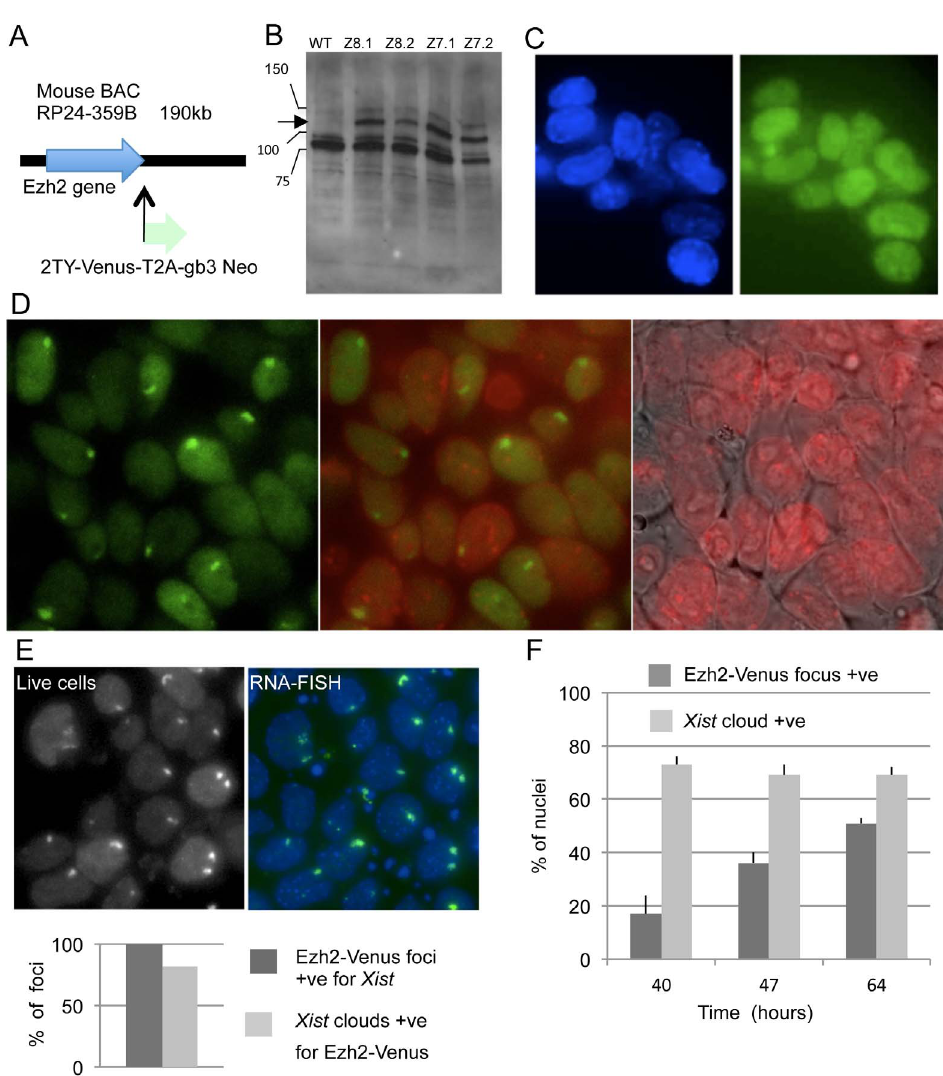
Fig. 2. The Ezh2-Venus protein is recruited at the nascent inactive X chromosome in differentiated ES cells. A) Schematic strategy for the COOH-tagging of the Ezh2 protein expressed from a mouse BAC DNA. B) Expression of the Ezh2-Venus fusion protein in ES cells. Western blotting using an Ezh2 antibody and nuclear extracts from the parental ES cell line HP3-10 (WT) and from four neomycin-resistant clones transfected with Venus-tagged BAC DNA The arrow points to the migration level of the fusion protein. C) Nuclear localization of the Ezh2-Venus fusion protein in fixed ES cells. Wide-field fluorescent microscopy for Hoechst 33342 (blue, left panel) and Venus (green, right panel) of the Z8.1 ES cells cultured in 2i plus LIF and fixed for 3 minutes with 4% PFA. D) Ezh2-Venus nuclear foci are detectable in differentiated live female ES cells. Live imaging was performed on the Z8.1 ES cells after differentiation for 50 hours. Nuclear fluorescent foci of Venus signal are visible (green, left and central panel). DNA was stained with Hoechst 33342 (pseudo- colored in red) and overlaid on the phase contrast image (right panel) and on the Venus channel image (central panel). E) Ezh2-Venus nuclear foci correspond to Xist RNA clouds. Live cells of the Z8.1 line differentiated during 70 hours were imaged for Venus (top-left panel) and then fixed and processed for Xist RNA-FISH (top-right panel; DAPI blue, Xist green). Despite moderate shifts due to live cell movements prior to fixation, both panels show recognizable nuclei presenting similarly localized Ezh2-Venus and Xist nuclear territories. All nuclear Ezh2-Venus foci detected in live cells corresponded to a Xist RNA cloud (bottom panel, n 5 60) although the reciprocal was not the same. F) In the course of differentiation, the kinetics of Ezh2-Venus foci is delayed as compared to the kinetics of Xist RNA accumulation. Duplicate samples at different time- points of the same differentiation experiment using the Z8.1 ES cell line, were processed for live imaging of Ezh2-Venus or for Xist RNA-FISH. Cells were counted for nuclear fluorescent territories after